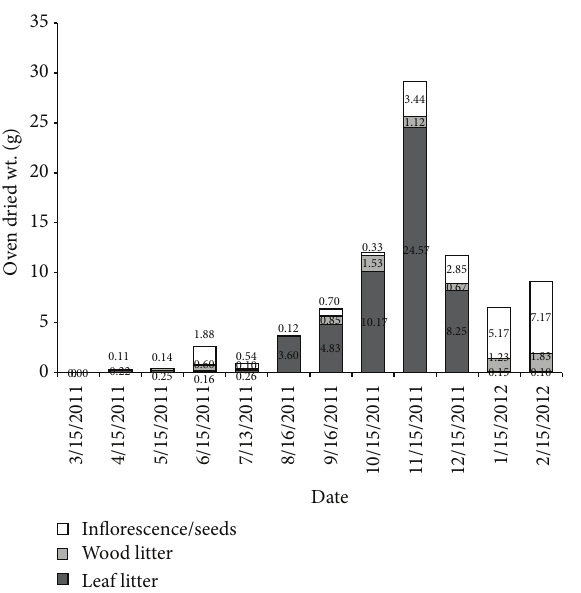
Figure 6: Patterns of litter